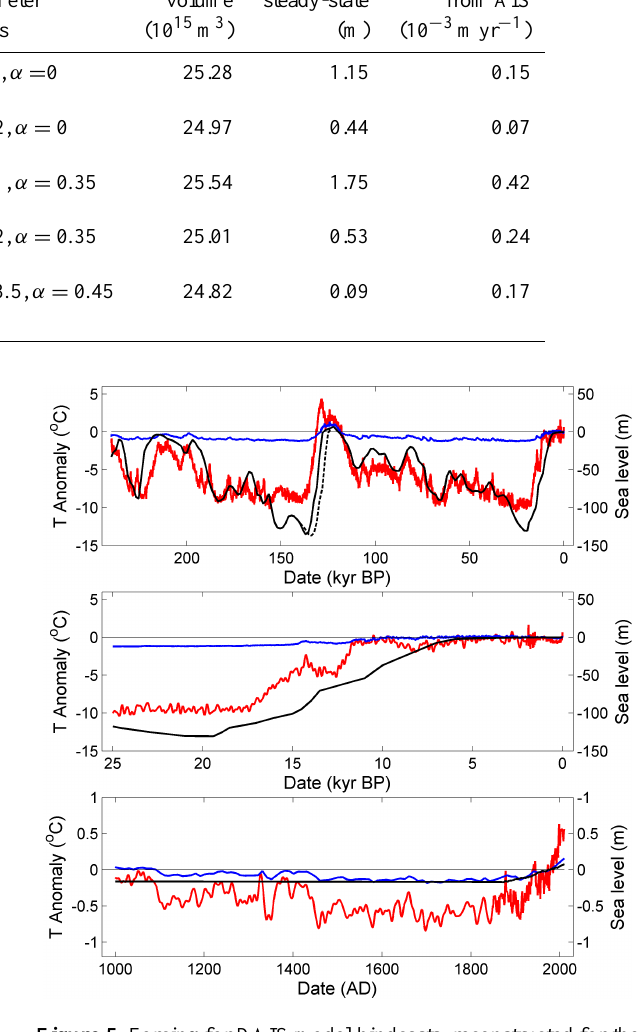
Figure 5. Forcing for DAIS model hindcasts, reconstructed for the period 240kyrBP to AD2010 (see Appendix A for details). Shown are the anomalies of Antarctic temperature reduced to sea level (red lines), sea level (black lines) and high-latitude, ocean subsur- face temperature (blue lines), all relative to their present-day values ( − 18 ◦ C, 0m and 0.72 ◦ C, respectively). The actual forcings are the anomalies with the addition of these present-day values. The lower two panes are enlarged sections of the full series (top pane). The dashed black line in the top pane shows the original Waelbroeck et al. (2002) sea level reconstruction for the period 140–122kyrBP (see discussion in Appendix